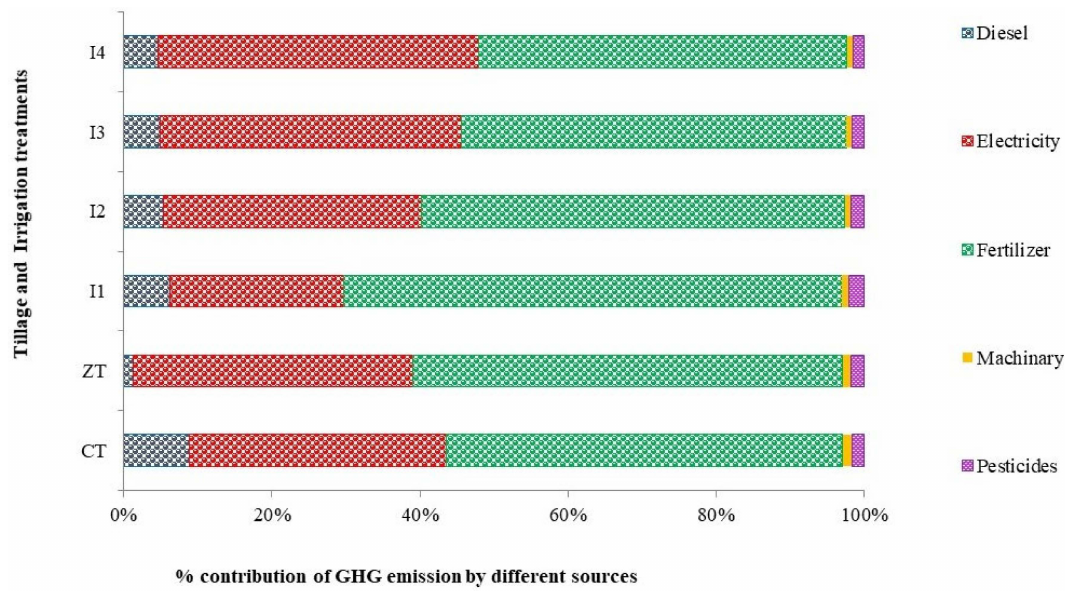
Figure 5. Percent share of GHGs emitted from different management practices.